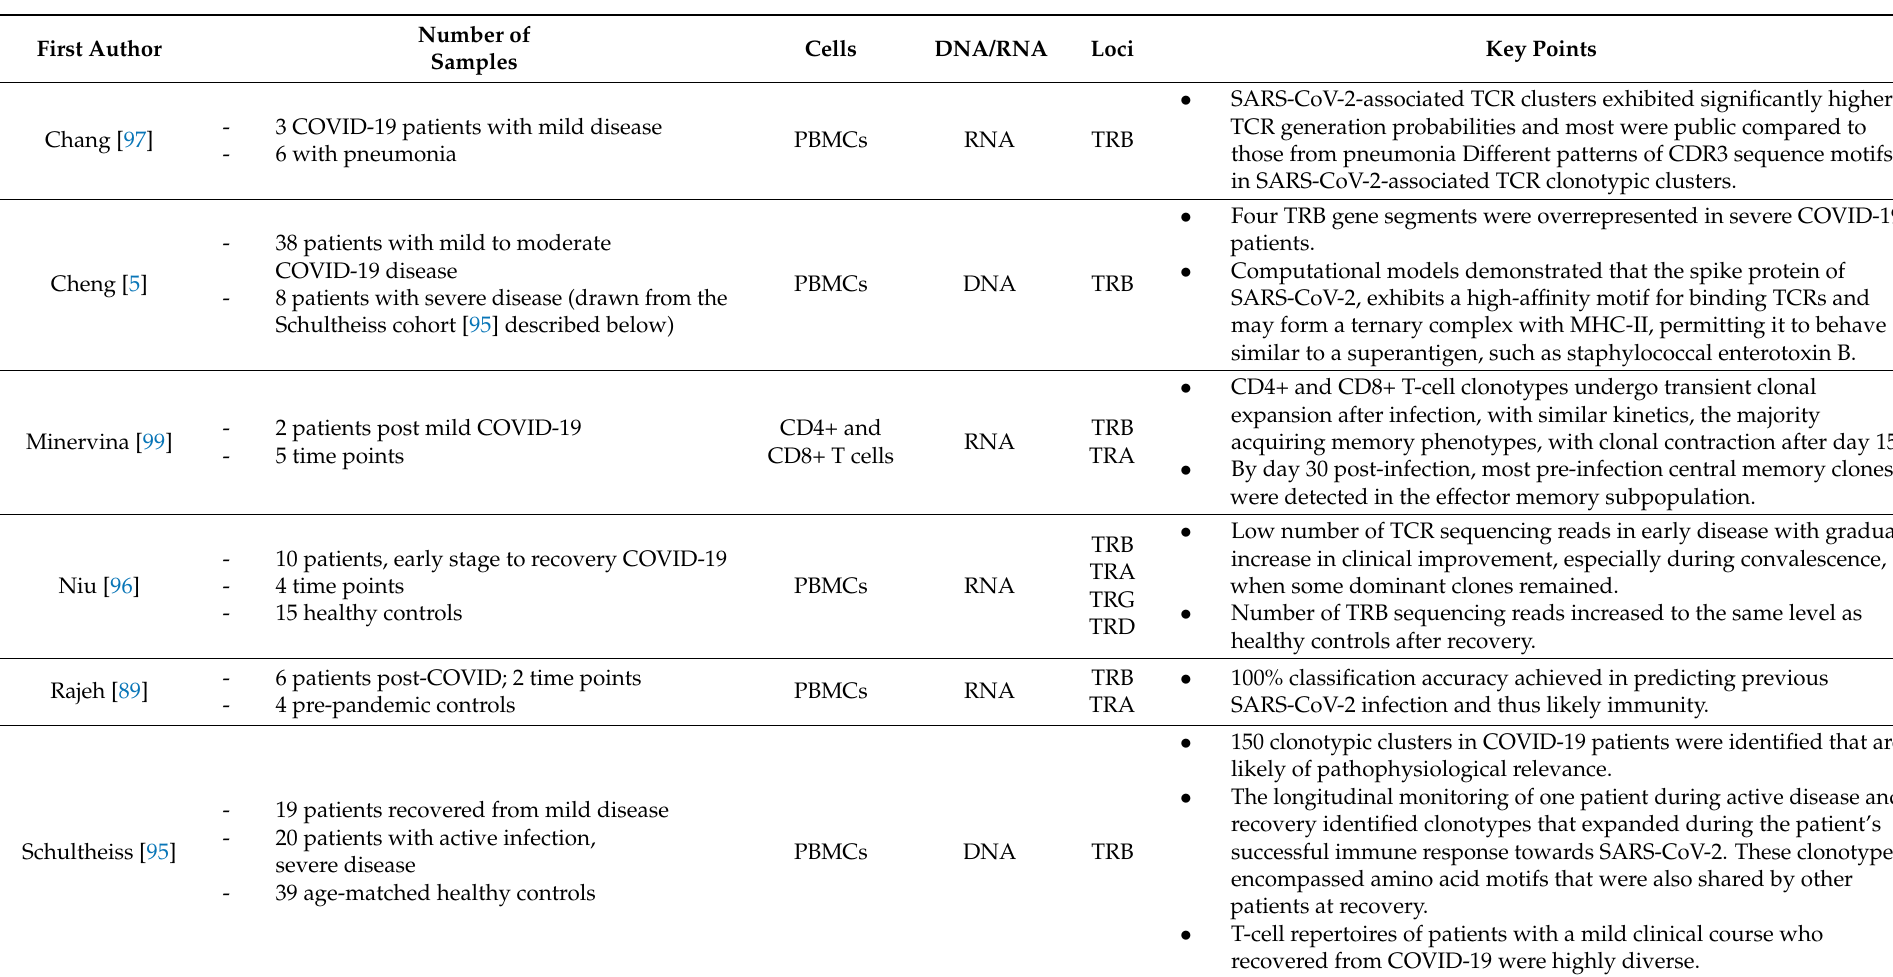
Table 4. Biological insights into COVID-19 from bulk TCR repertoire